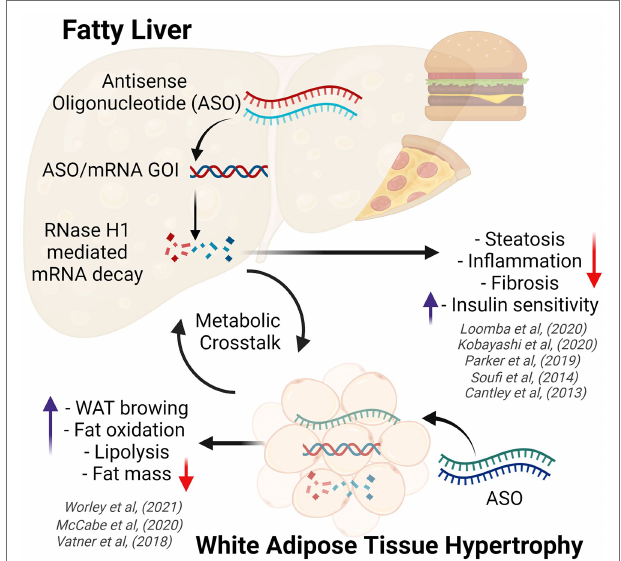
FIGURE 1 | Diagram demonstrating the effects of obesity on white adipose tissue and the liver (fatty liver disease), highlighting key metabolic benefits conferred by antisense oligonucleotide therapy. ASO, antisense oligonucleotides; GOI, gene of interest; WAT, white adipose tissue. Created with